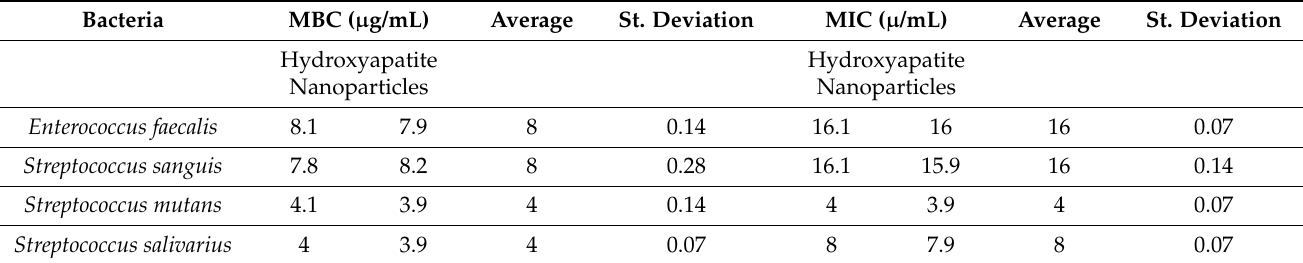
Table 3. Minimum Inhibitory Concentration (MIC) and Minimum Bacterial Concentration (MBC) of HAPNPs.